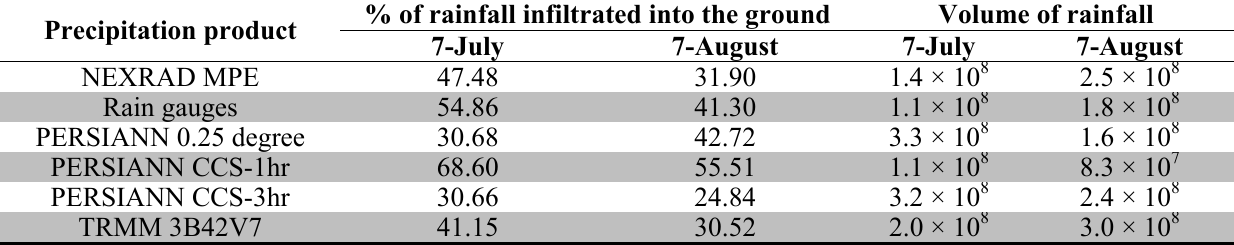
Table 8. Percentage of rainfall volumes infiltrated into the ground and volume of rainfall amounts for the two